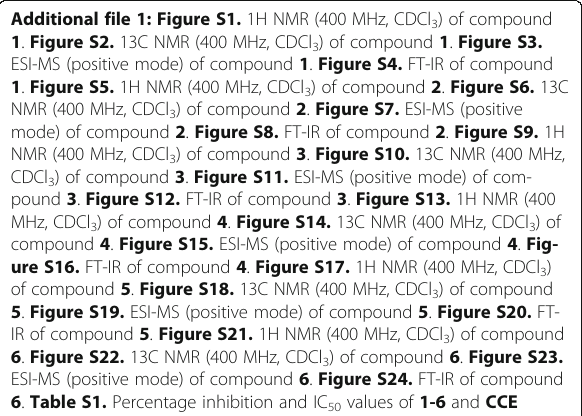
5 . Figure S19. ESI-MS (positive mode) of compound 5 . Figure S20. FT- IR of compound 5 . Figure S21. 1H NMR (400 MHz, CDCl 3 ) of compound 6 . Figure S22. 13C NMR (400 MHz, CDCl 3 ) of compound 6 . Figure S23. ESI-MS (positive mode) of compound 6 . Figure S24. FT-IR of compound 6 . Table S1. Percentage inhibition and IC 50 values of 1-6 and